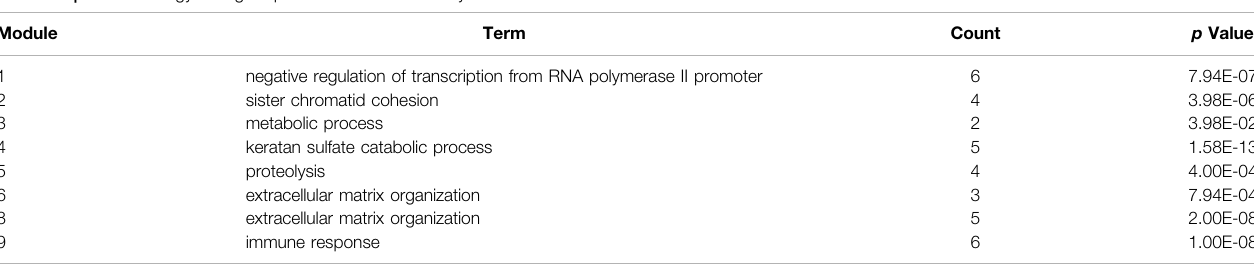
TABLE 1 | Gene ontology biological process enrichment analysis.